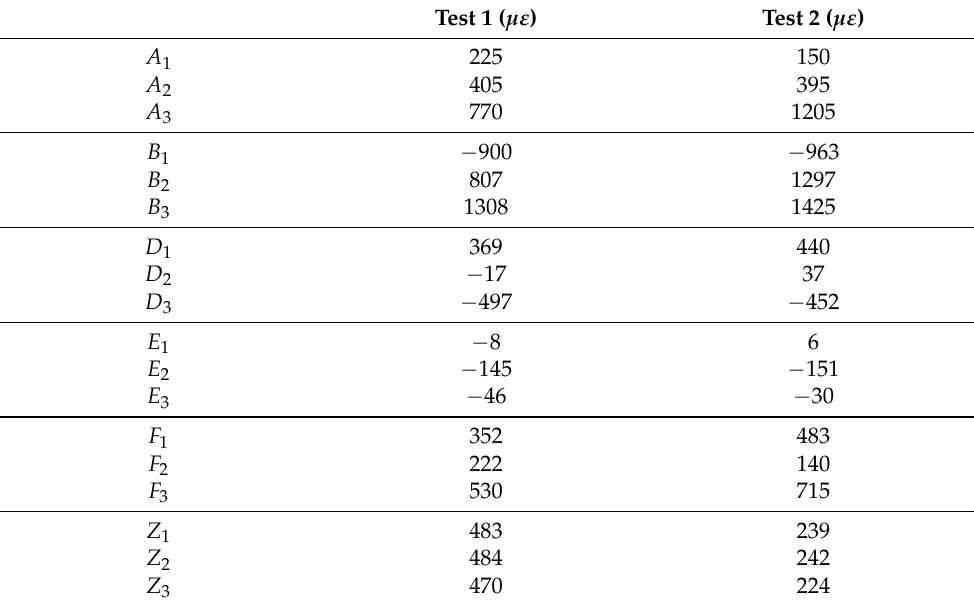
Table 1. Strain measured at each cross-section at 2 instants of the experiment